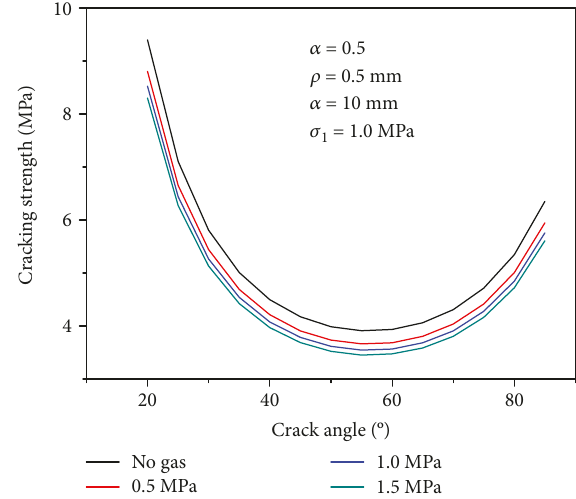
Figure 13: Relationship of cracking strength against crack angle under di ff erent gas pressures.